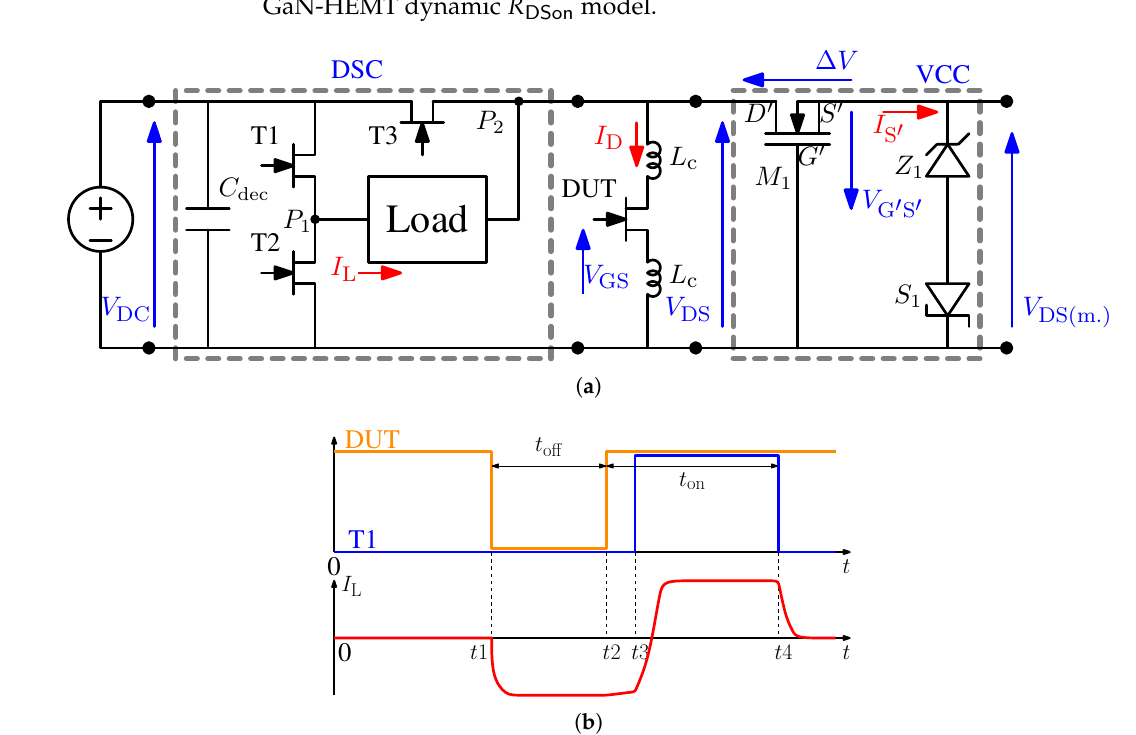
Figure 9. Measurement circuit and control signal: ( a ) Electrical circuit. ( b ) Control signals and load